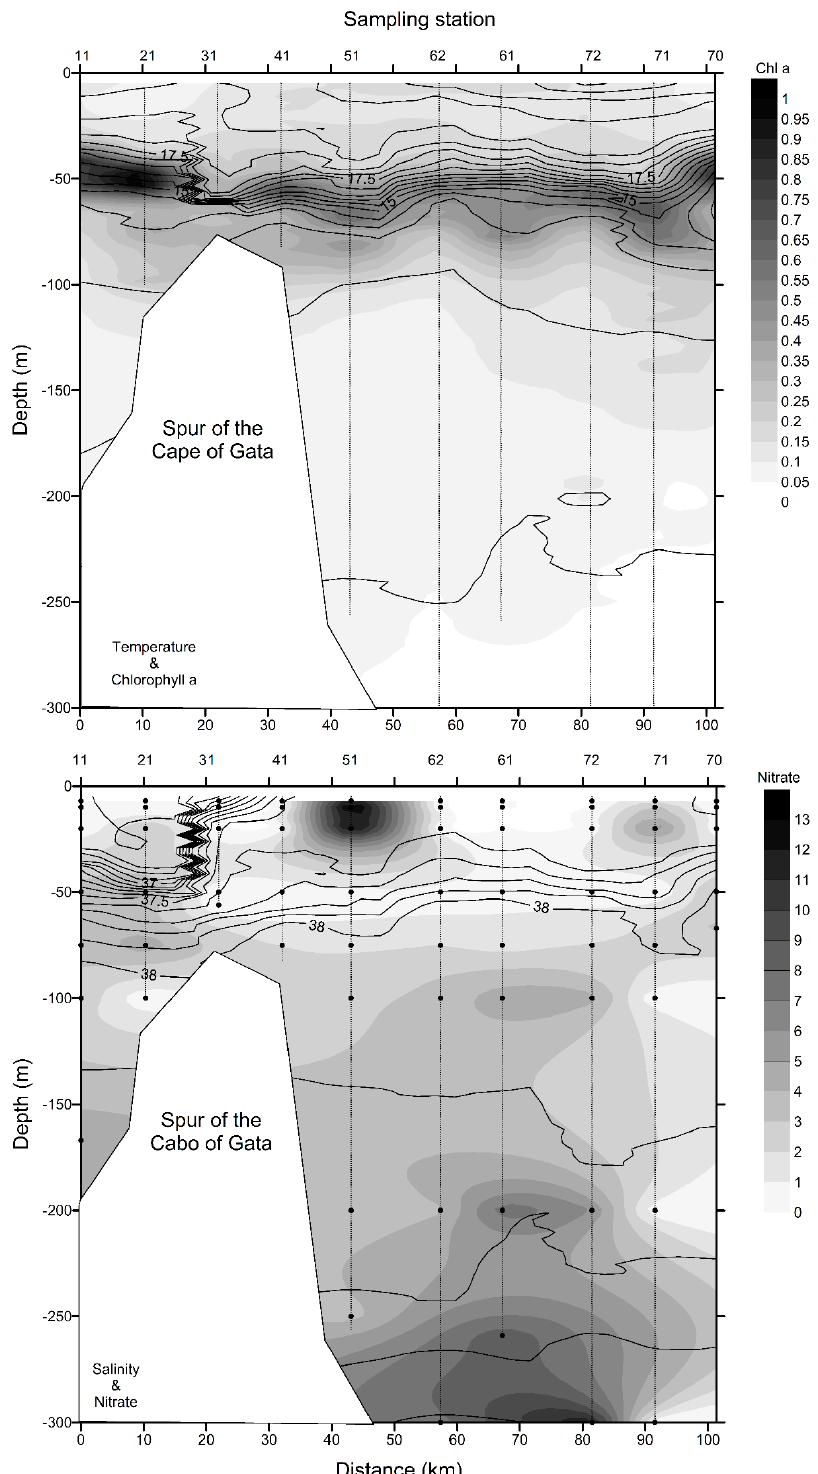
Figure 6. Coastal transect (Stn 11 to Stn 70). ( a ) Temperature (°C, black labelled lines) and chlorophyll a concentration (mg ∙ m − 3 , greyscale); ( b ) salinity (black labelled lines) and nitrate concentration ( μ M, greyscale).